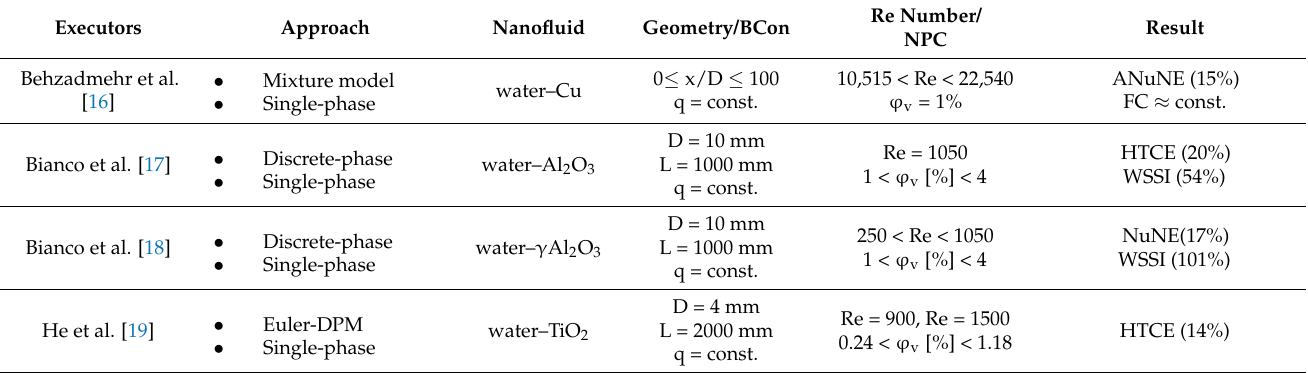
Table 2. Numerical studies dealing with two-phase